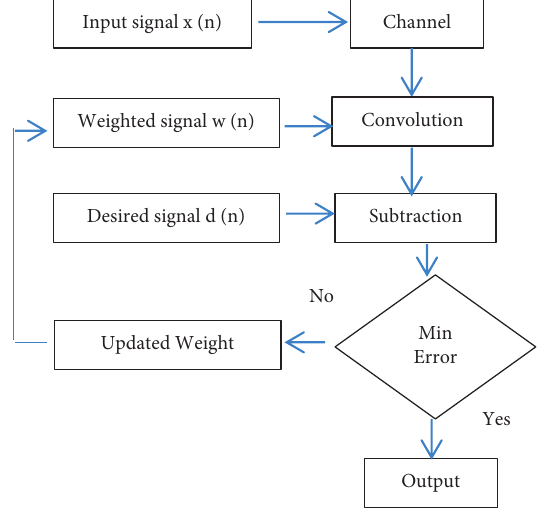
Figure 2: Flow chart of LMSA for weight updating